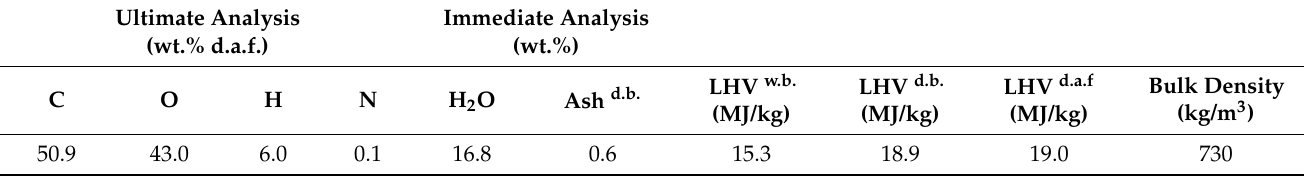
Table 3. Properties of the raw olive